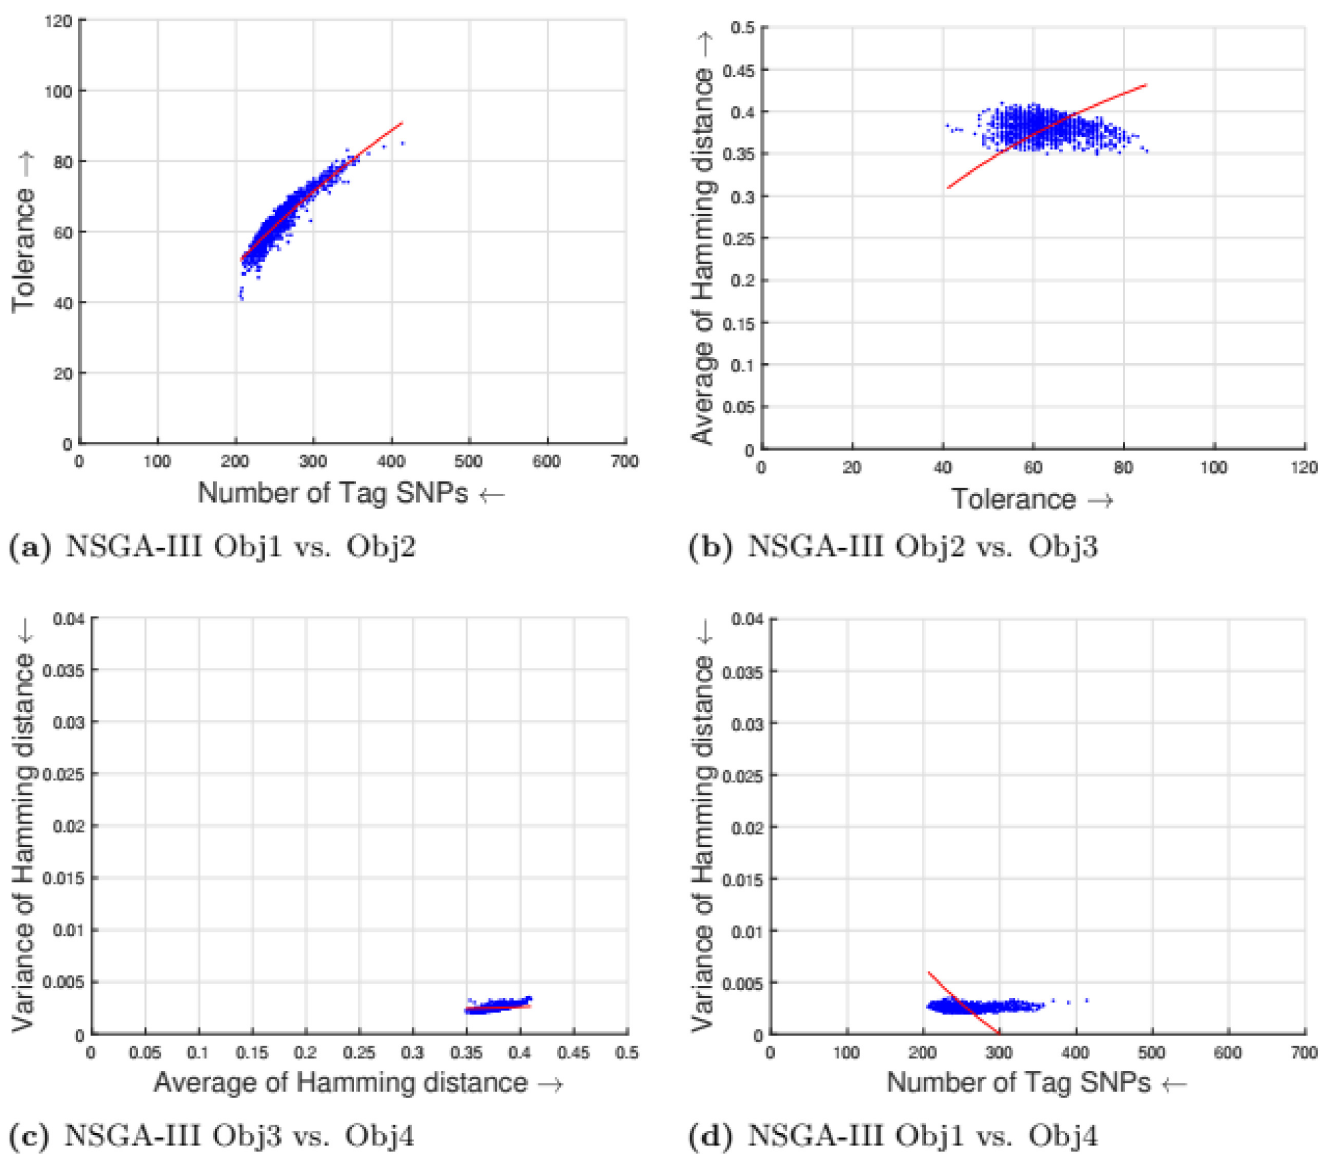
Fig 3. Experimental results of NSGA-III for the tag SNPs selection using random initialization. Obj1 stands for the number of tag SNPs, Obj2 is the tolerance for missing data, Obj3 measures the average Hamming distance between alleles, and Obj4 controls the variance of detection power in each allele. (a) NSGA-III Obj1 vs. Obj2, (b) NSGA-III Obj2 vs. Obj3, (c) NSGA-III Obj3 vs. Obj4, (d) NSGA-III Obj1 vs. Obj4.